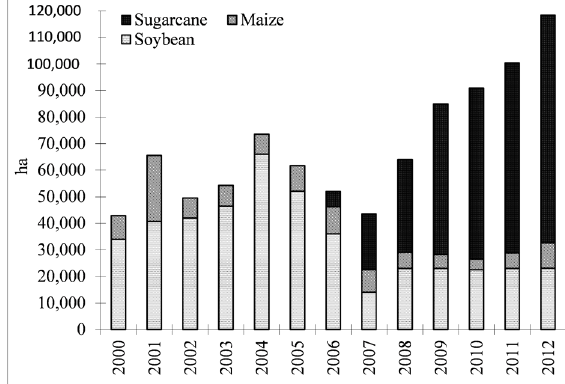
Figure 3 - Soybean, maize and sugarcane cropped area in Quirinópolis and Gouvelândia municipalities, Goiás, Brazil. Source: IBGE (2012), CANASAT